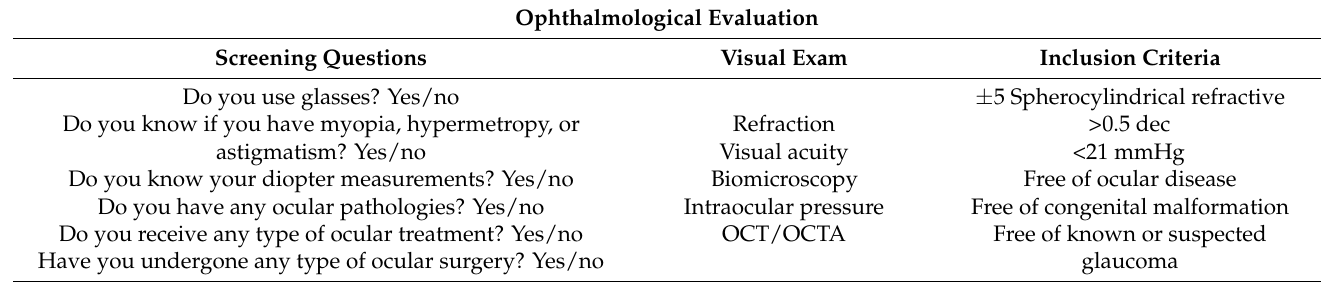
Table 1. Ophthalmological evaluation of COGDEM participants. Ophthalmological